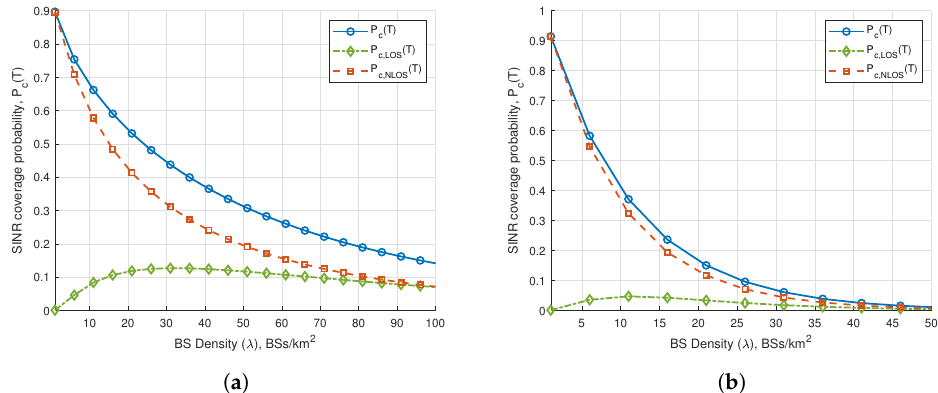
Figure 5. Impact of BS density on SINR coverage probability for different blockage environment. ( a ) obstacle scaling factor, ζ = 1 ( b ) obstacle scaling factor, ζ =